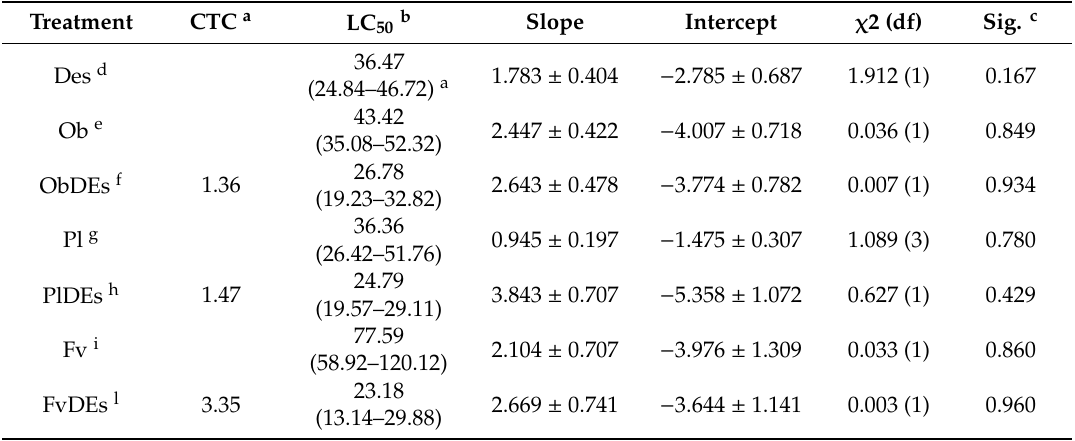
Table 3. Toxicity of the essential oils of Pistacia lentiscus , Ocimum basilicum , and Foeniculum vulgare , inert dust and of their combination against adults of Sitophilus granarius